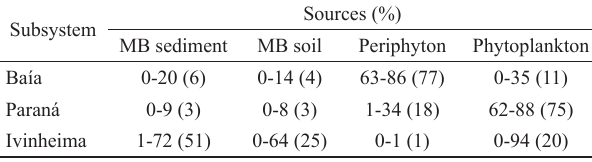
Tab. 3. Contributions of carbon sources to nutrition of